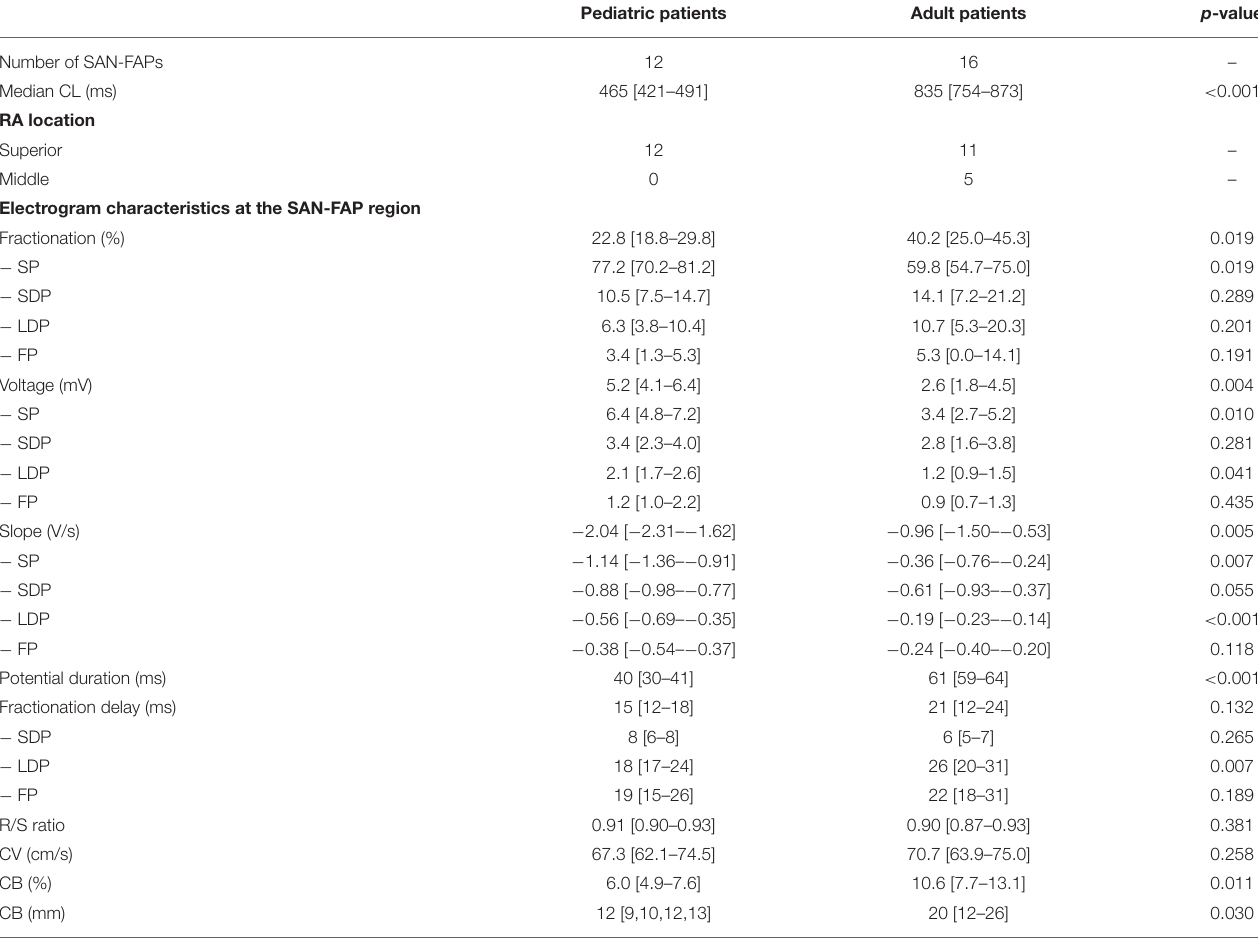
TABLE 2 | Characteristics of SAN-FAPs.